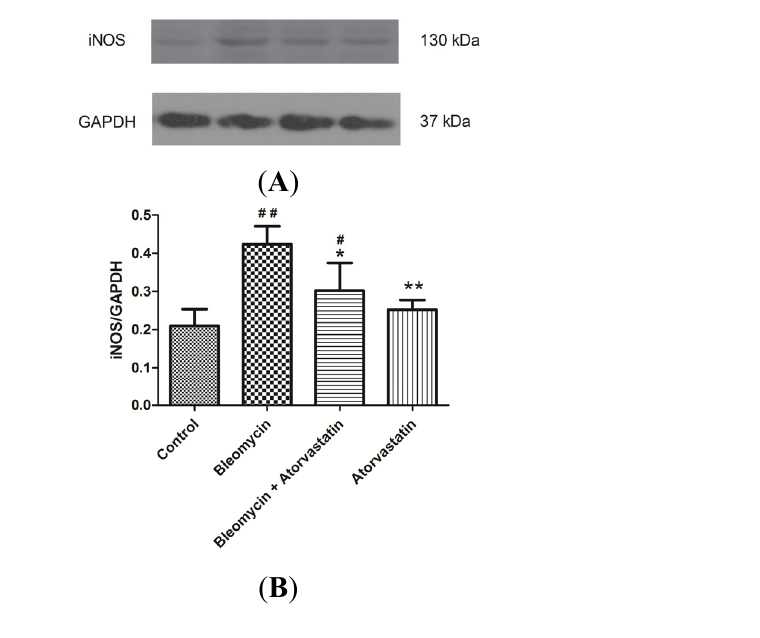
Figure 5. Western blot analysis of iNOS levels in the lungs of bleomycin-induced pulmonary fibrosis rats. The increased levels of iNOS protein expression were significantly inhibited by administration of atorvastatin. ( A ) Representative blots are shown and protein size is expressed in kDa; and ( B ) Densitometric quantification data are expressed as the intensity ratio of target proteins to GAPDH (mean ± SD, n = 5). # p < 0.05 and ## p < 0.01 vs. the control group, respectively; * p < 0.05 and ** p < 0.01 vs. the bleomycin group,